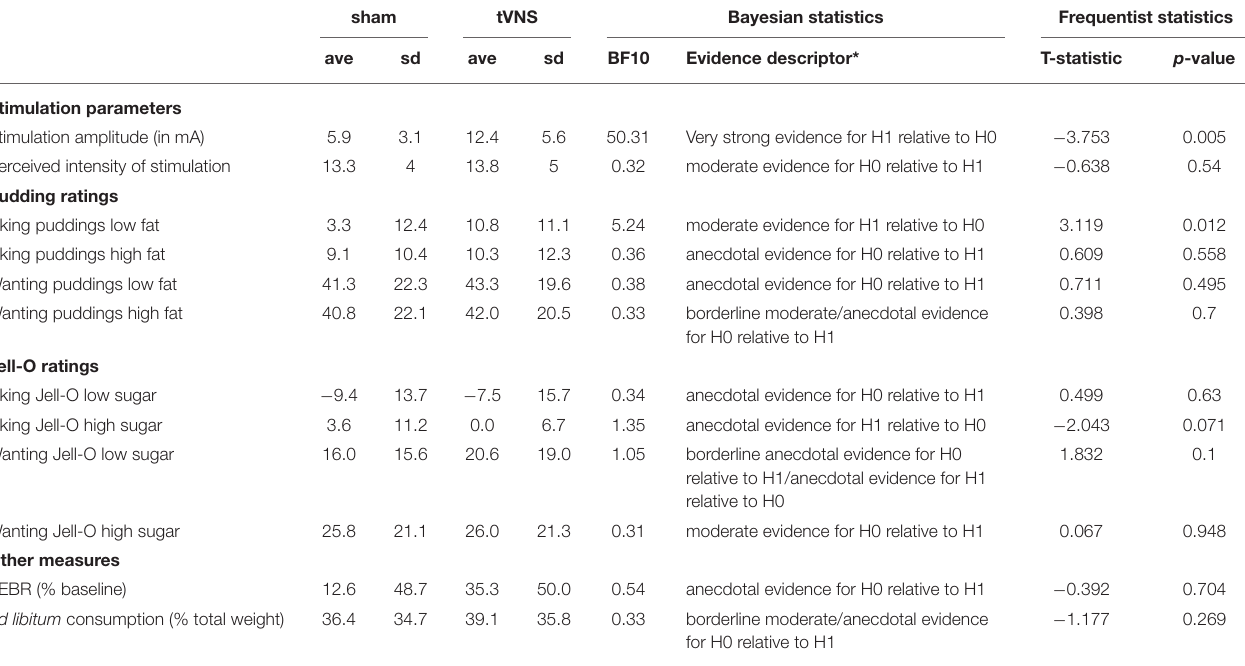
TABLE 1 | Descriptive statistics, Bayesian statistics, frequentist